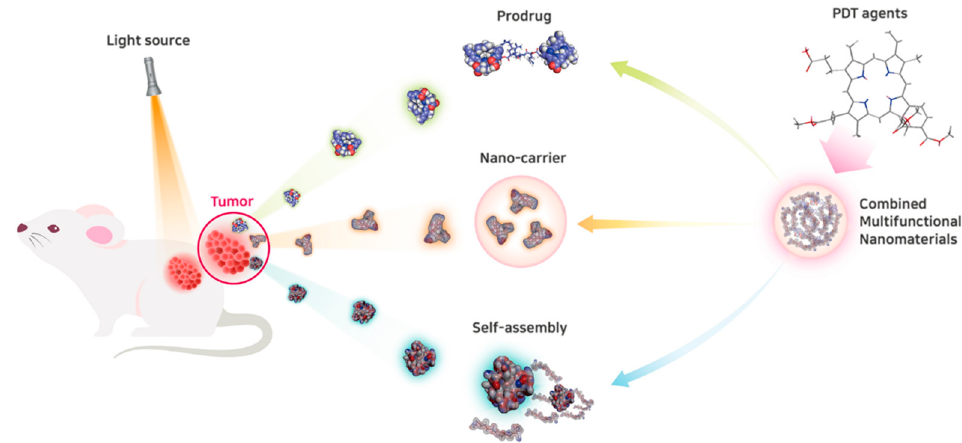
Figure 1. Schematic representation of nanomedicine for photodynamic therapy (PDT). Accumulation of photosensitizers in the tumor site can be enhanced by nanocarriers. In addition, prodrug nanomedicines for PDT can be activated by such stimuli as enzymes in the tumor site. Self-assembly of amphiphilic polymers may provide good loading efficiency and sustained release of hydrophobic photosensitizers.